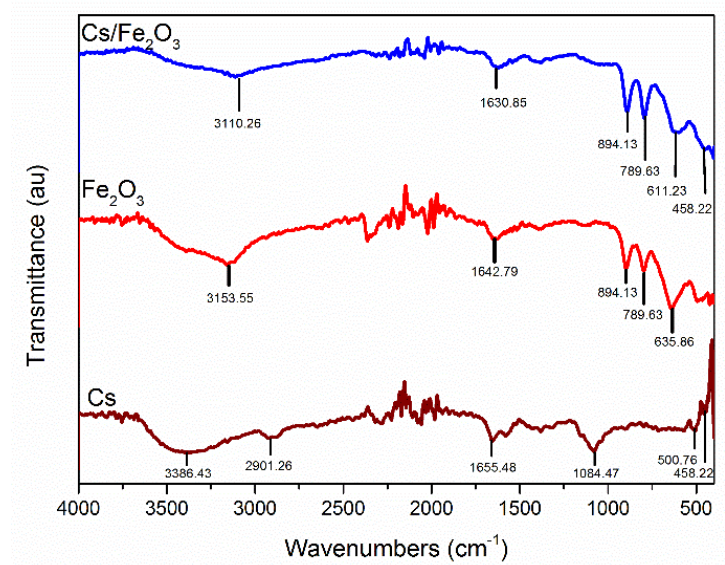
Figure 2. FTIR spectrum for chitosan, Fe 2 O 3 and Cs/Fe 2 O 3 thin films.